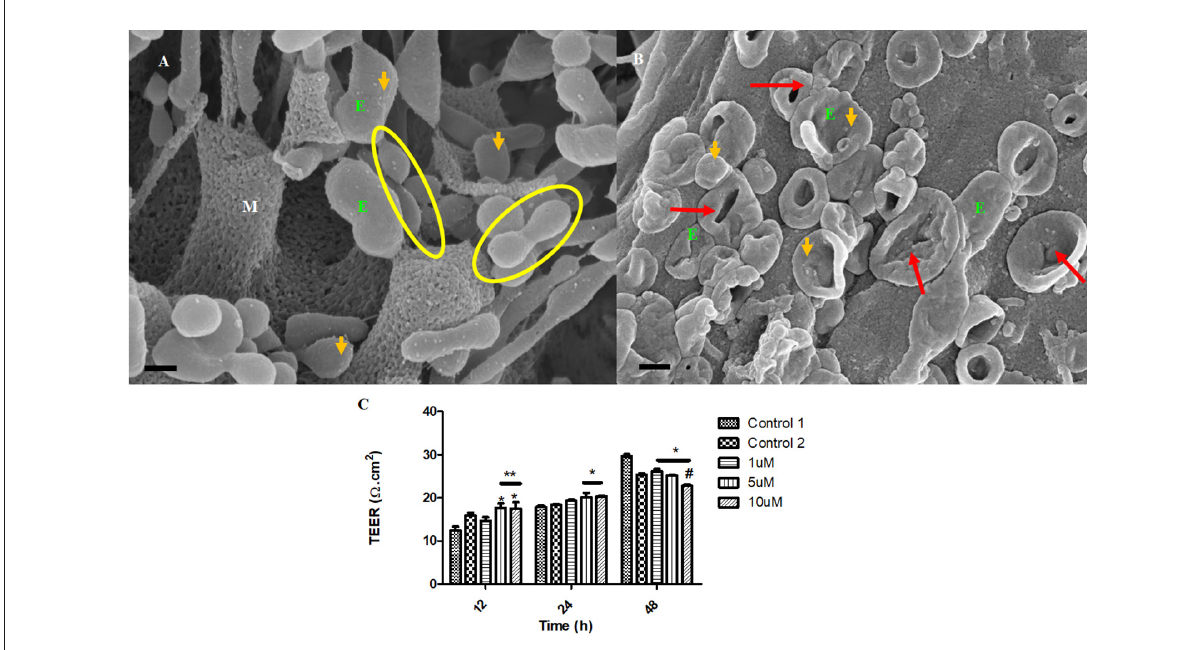
FIGURE10 The accumulation of the exosomes on the BEC membrane surface and exosome-derived NT formation initiate BEC-cell communication. (A) The untreated control sample of BECs exhibiting spherical exosomes released onto the plasma membranes of the BEC. Scale bar = 200 nm. (B) The BECs were treated with 1 µ m of Tipifarnib for 24 h. E denotes the exosome, indicated by the orange arrows. The red arrows indicate visible exosome collapse upon treatment with Tipifarnib. Scale bar = 300 nm. (C) A graphical representation of the effect of Tipifarnib on BEC (bEnd5) permeability upon 12 h, 24 h, and 48 h treatment. The single asterisk denotes statistically significant differences between the experimental sample and Control 1; the double asterisk denotes statistical differences between the experimental samples and Control 2; and the Hash denotes significant differences between 10 µ M and 10 µ M